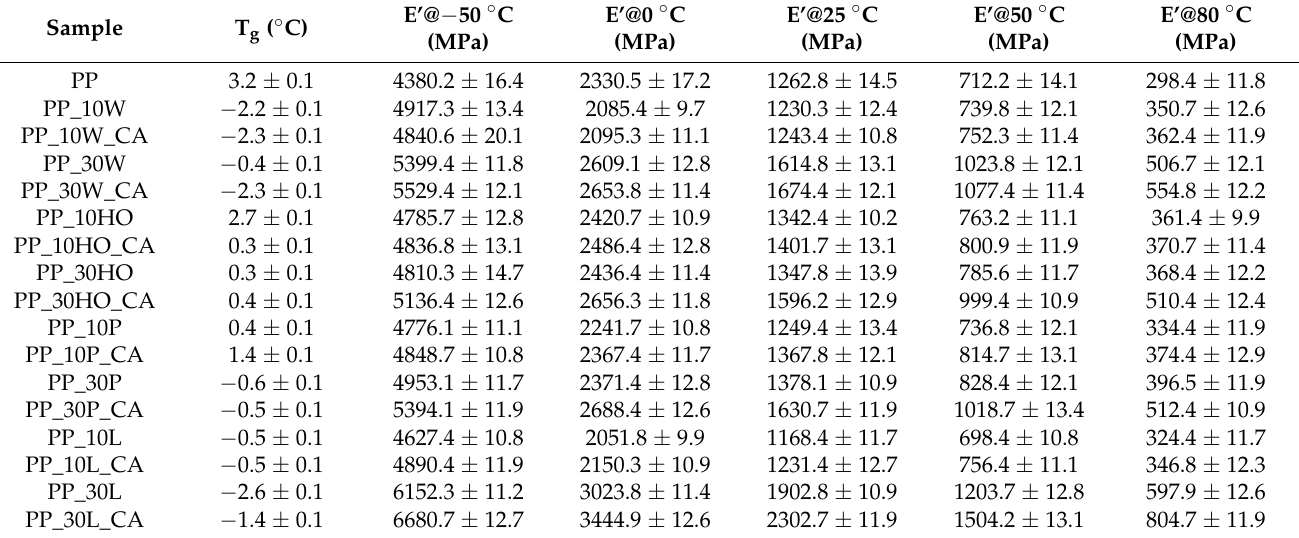
Table 6. Glass transition temperature (T g ) and storage modulus values (E’) of PP-based composites at different